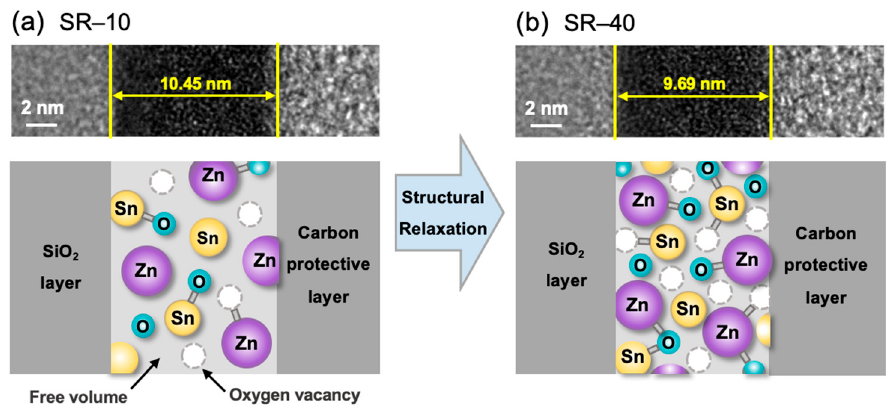
Figure 1. TEM images ( top ) and corresponding schematics ( bottom ) for ( a ) SR-10 and ( b ) SR-40. The schematics illustrate the change produced in the atomic structure by structural relaxation.